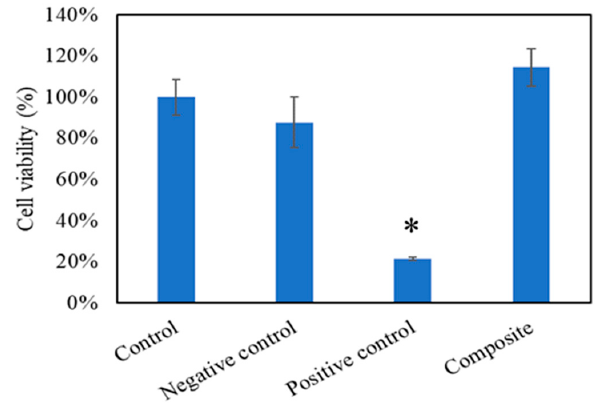
Figure 6. WST-1 test ( n = 6). Control group was 100% cell viability, negative control was aluminum oxide, and positive control was zinc diethyldithiocarbamate. The results showed that the Gel-HA/CS/HAP composite had no cell toxicity. * p < 0.001.